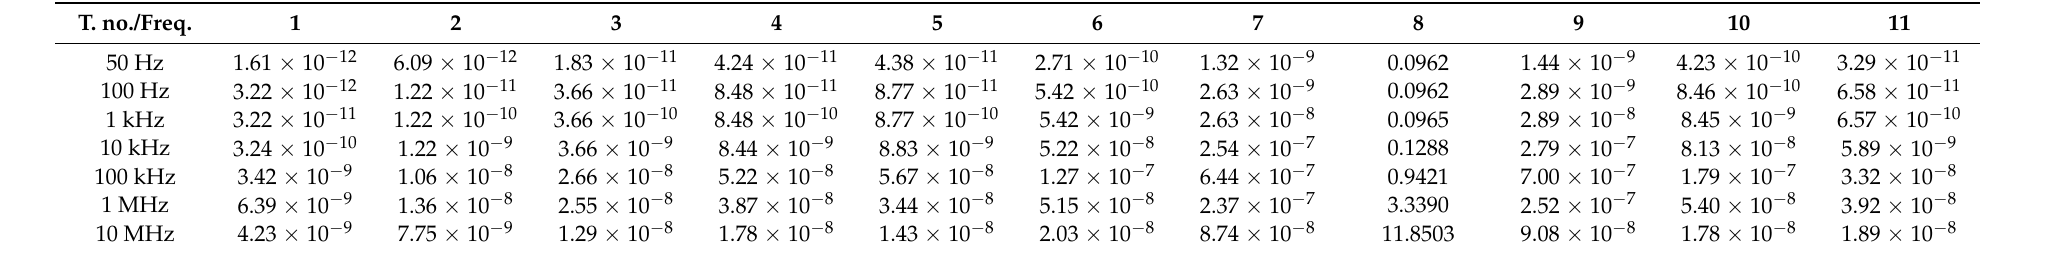
Table A17. Self and mutual resistances of turn 8 (in Ω ) resulting from FEM simulations. T.